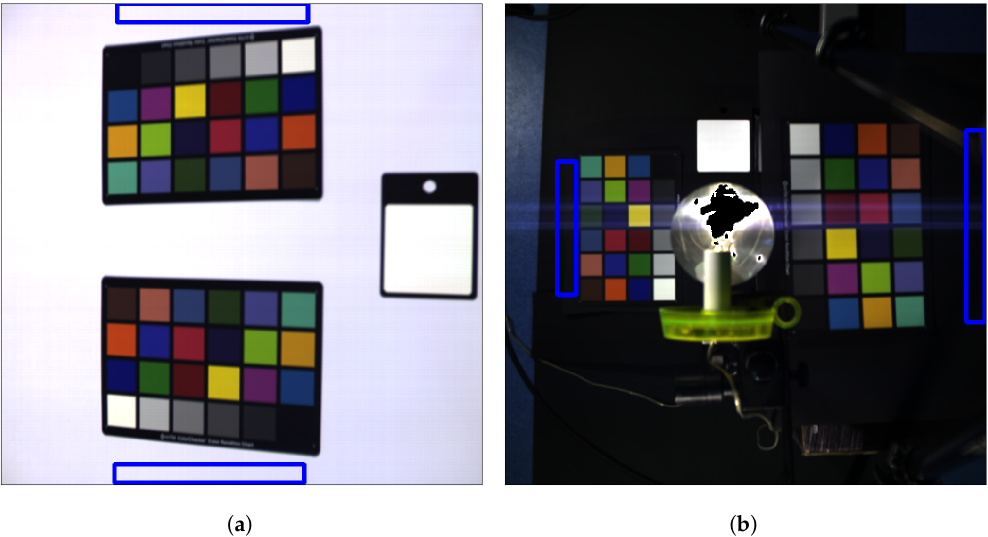
Figure 5. Collected background regions, ( a ) in image ‘N09’, ( b ) in image